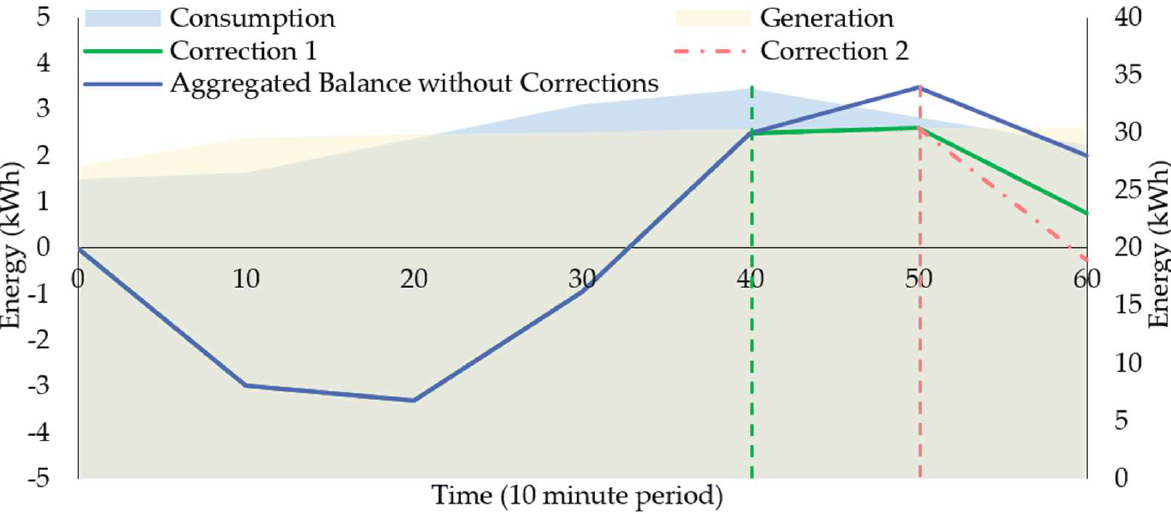
Figure 4. DR event monitoring for the period of 11:00 a.m.